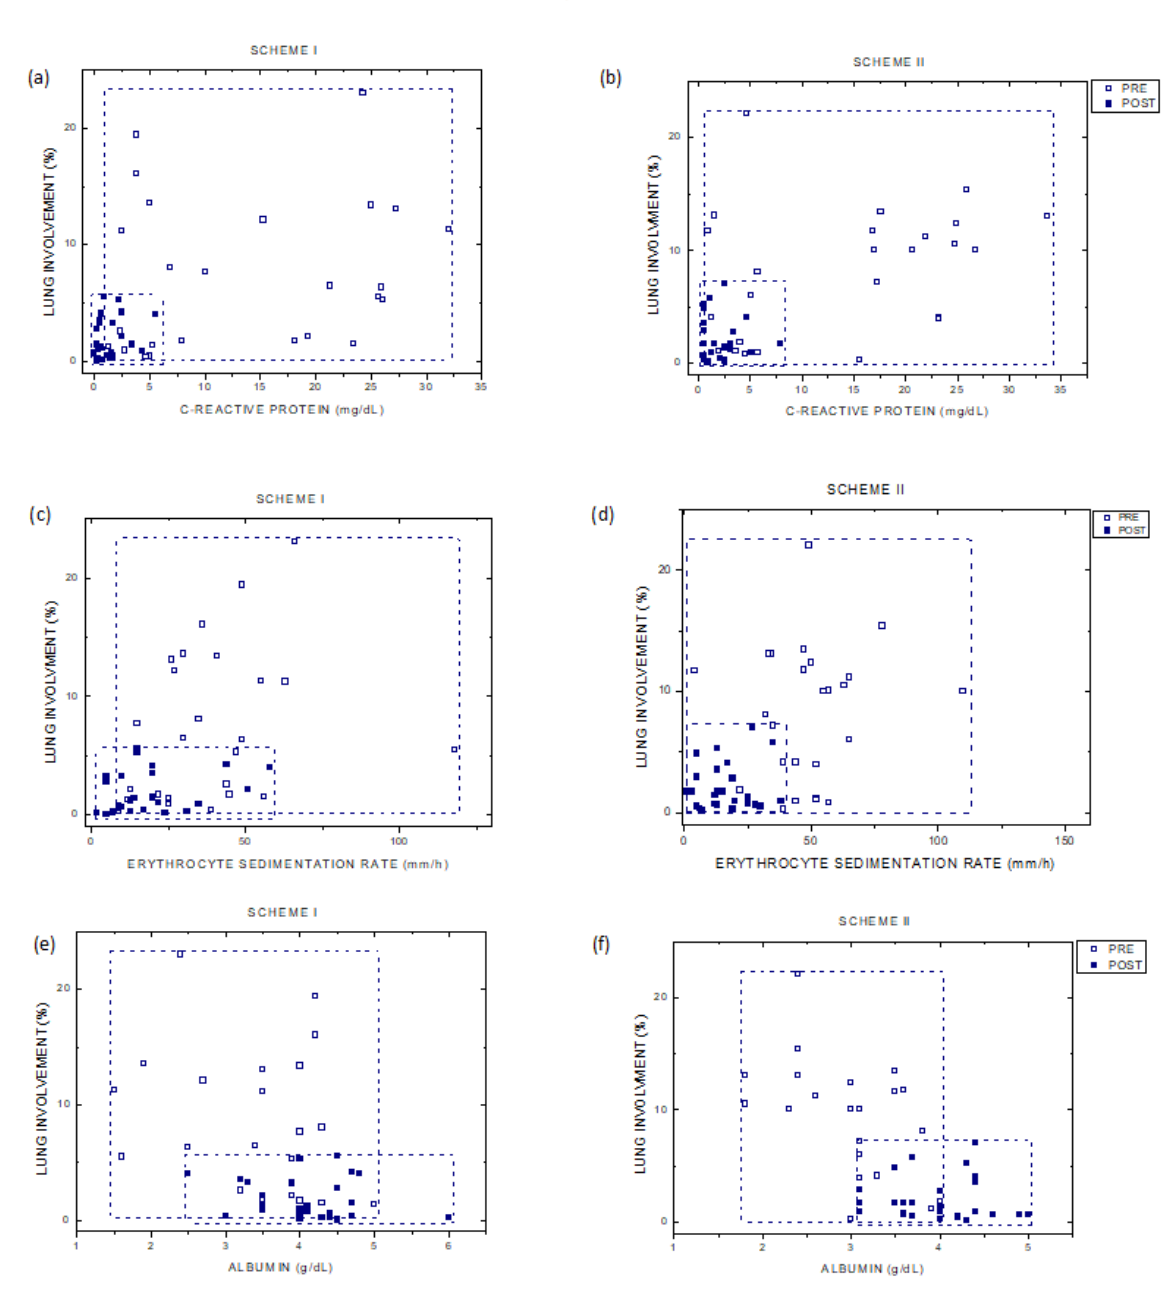
Figure 3 Panel of patient maps and serum index - Ordinate in the plots represents the lung-involvement percentage and abscissa the correspondent serum index. The first panel line shows the lung-involvement percentage versus the C-reactive protein levels for Scheme I (a) and Scheme II (b). The second panel line displays the lung-involvement percentage versus erythrocyte sedimentation rate for Scheme I (c) and Scheme II (d). Third line is the lung-involvement percentage versus the albumin levels for Scheme I (e) and Scheme II (f). Statistical analysis by Mann Whitney with p > 0.05 between Schemes I and II. Open square (full square) represent patients results pre- (post-) treatment. As expected, a clear reduction of sample area was observed posttreatment, with serum indices within the normal range of values. The plots show that the novel 3D reconstruction method of evaluate lung involvement accompanies the reduction in the serum